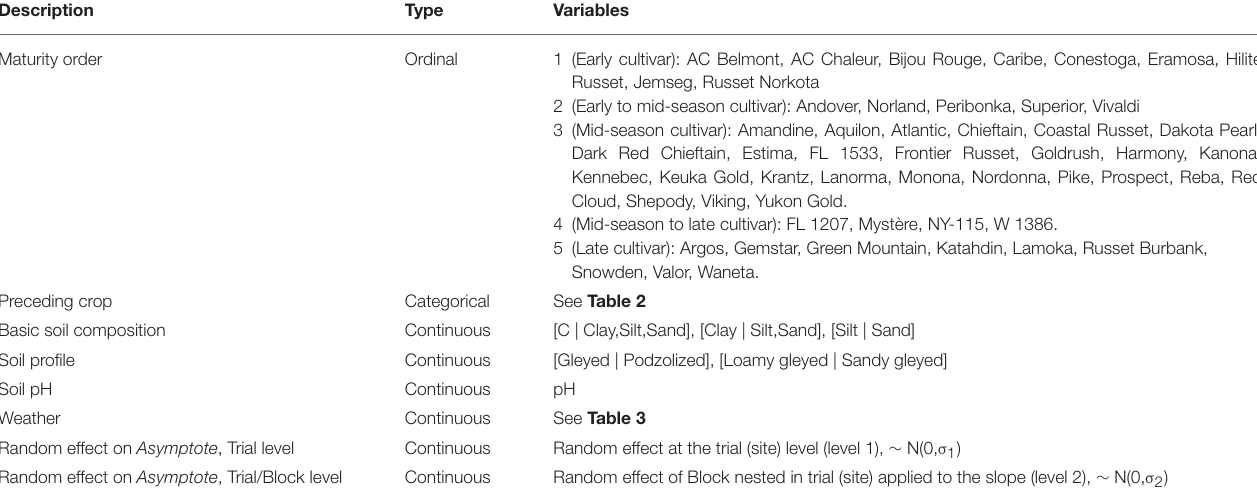
TABLE 1 | Variables used in the multilevel models.